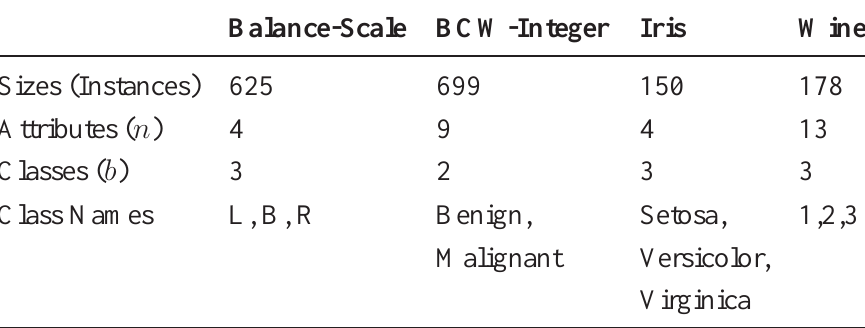
Table 3. Description of